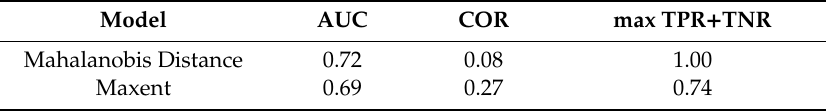
Table 4. Results of the top three quantiles (70 th , 80 th , 90 th ) for the quantile regression of the normalized cell tenure (NCT) values on SDM model scores. Results of the quantile regression indicate that our NCT values are well correlated with the SDM modeled suitability scores.